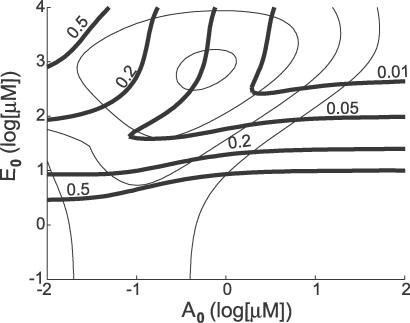
Comparison of the Complete and Reduced Models for the GEF–GAP Cycling Control ModuleThe Euclidean distance between the flux vectors of complete and reduced models was computed as described in Methods and normalized by the magnitude of the flux vector for the complete model. The profile of the normalized distance is shown by thick solid contour lines. The profile of the performance index P (same as Figure 3C) is shown by a thin line for comparison. Note that in the parameter region where the GTPase cycles with a high activity and turnover rate, the difference between the complete and reduced models is 5% or less.